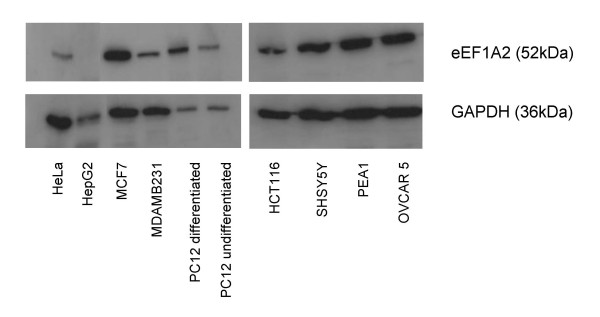
Western blot analysis using an anti-eEF1A2 antibody on a range of cell lines. The loading control is GAPDH.